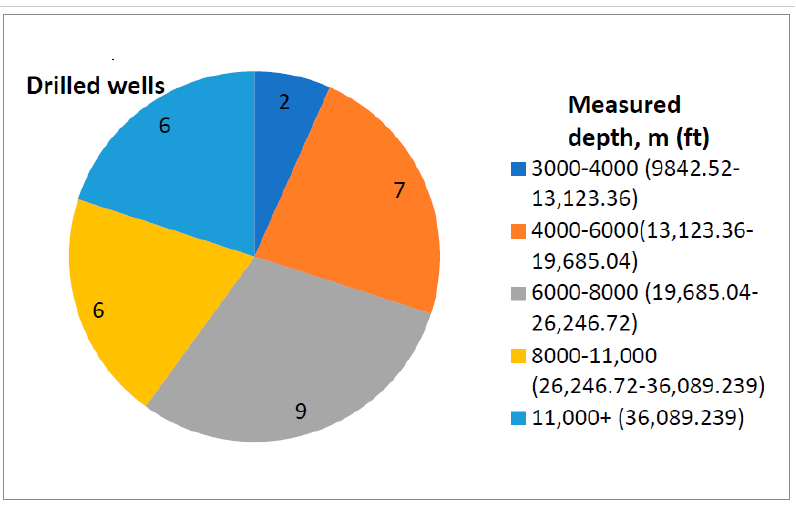
Figure 7. Measured depth of 30 analyzed wells.